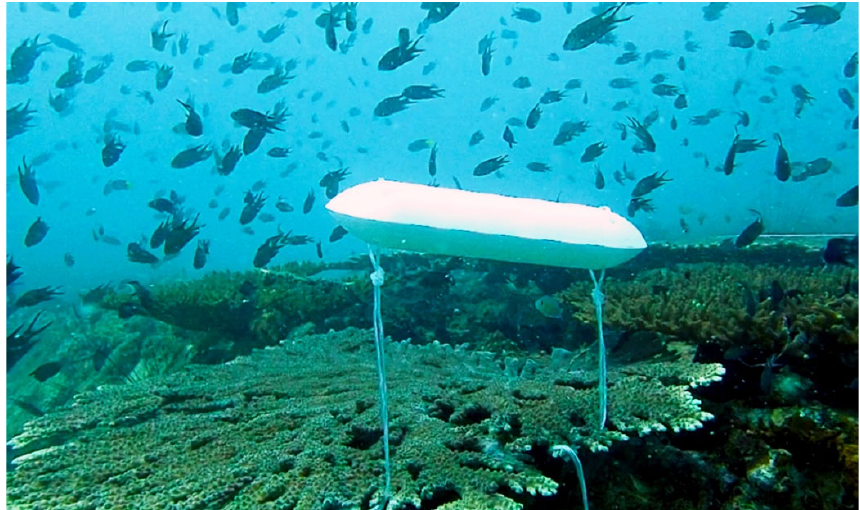
Figure 10. A school of pomacentrid fish (damselfish) surrounding hard corals that grew on top of the bioceramic plate of the BK AR module. A white-color buoy was placed on top of the AR as a reference for estimating the length of the fish.